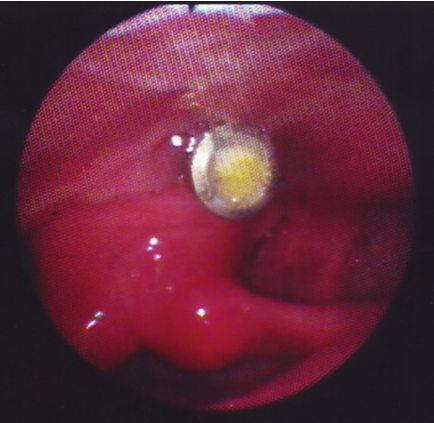
Figure 1: At laryngoscopy, the upper part of the screw is clearly visible in the postcricoid area, just above the entrance of left pyriform sinus.